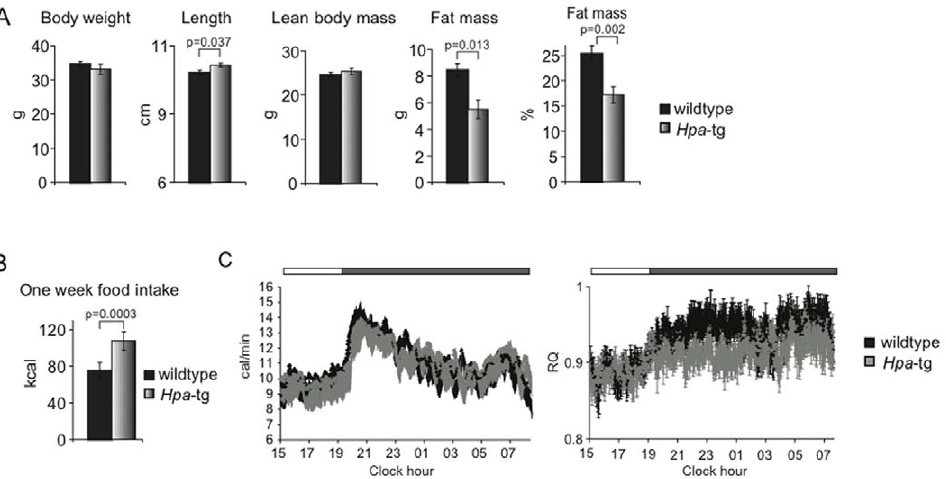
Figure 2. Reduced fat mass but increased food intake by Hpa -tg mice. (A) Body weight and body composition determined by DEXA analysis of Hpa -tg mice (n=9) and wt controls (n=8), age 12 weeks. No significant differences in lean body mass or body weight were detected, whereas the Hpa -tg mice showed reduced fat mass, and increased body length (nose-anus measurement). (B) Increased food intake by Hpa -tg (n=5) compared to wt control mice (n=4) during one week on normal chow. These animals were 36–37 weeks old, thus older than the mice tested in Fig. 1C. Mice were individually housed and weighed before and after the experiment. (C) Indirect calorimetry measurements on the animals (27 weeks old) showed no difference in energy expenditure (left panel) but a marked tendency toward lower RQ (right panel, p=0.09 based on areas under the curves) for Hpa - tg mice.